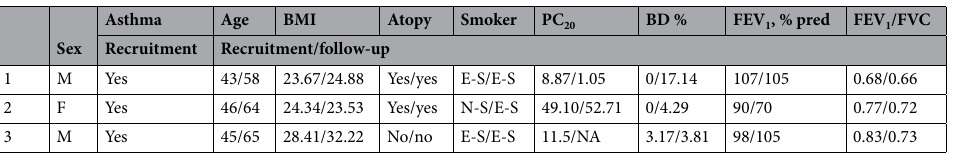
Table 3. Parameters of the three participants who reported a disappearance of asthma symptoms at follow-up. BMI body mass index (kg/m 2 ), BD bronchodilator response, E-S ex-smoker, FEV 1 forced expiratory volume in 1 s, FVC forced vital capacity, N-S non-smoker, NA not available, PC 20 provocative concentration for a 20% decrease in FEV 1 , S smoker.